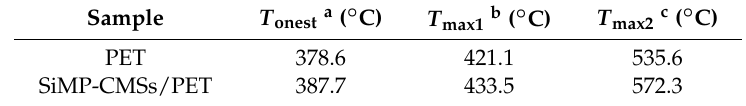
Table 5. Thermal stability and degradation of the SiMP-CMSs/PET composites.